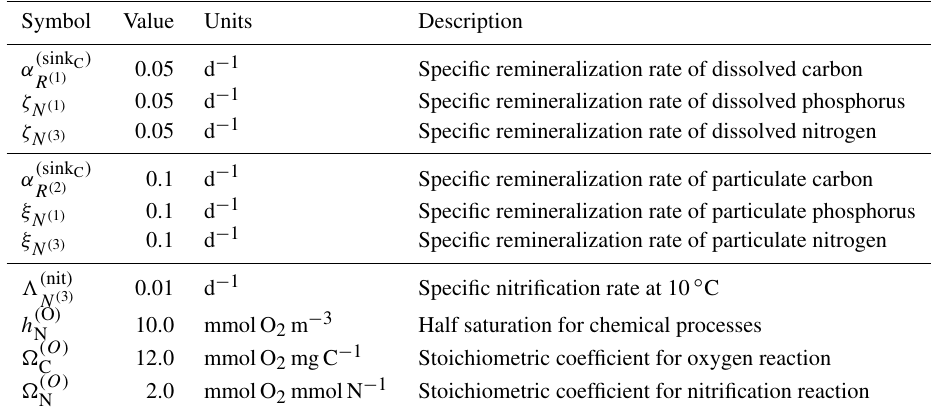
Table A5. Values, units, and descriptions for dissolved organic matter, particulate organic matter, and nutrient parameters within the BFM17 pelagic